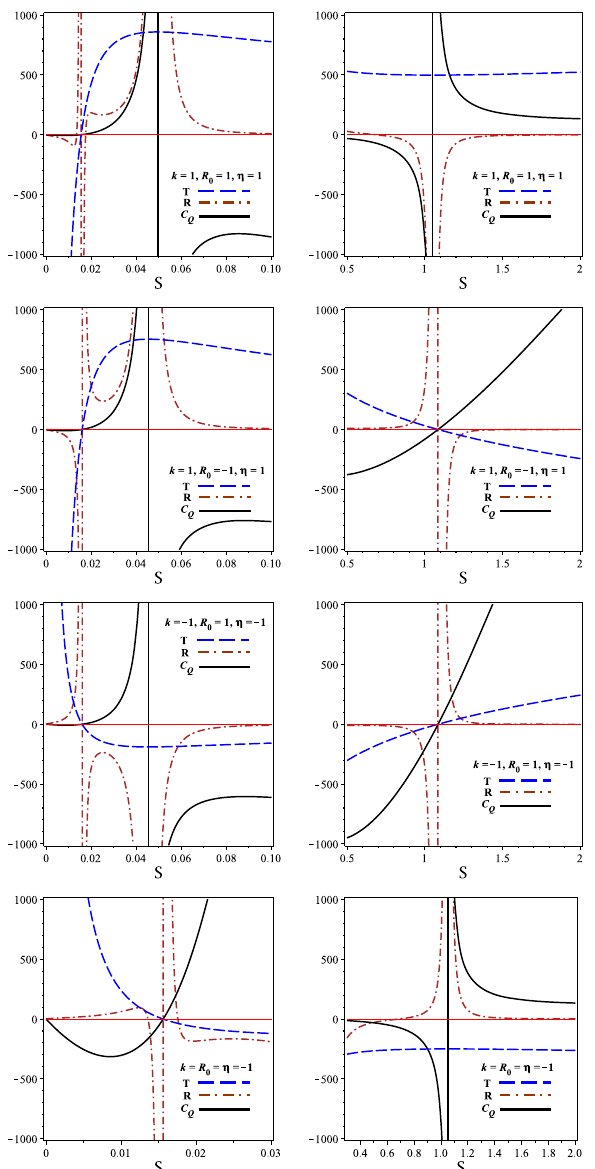
Fig. 3 The heat capacity ( C Q ) and temperature ( T ) and Ricci scalar ( R ) versus S for Q = 0 . 02 and f R = 0 . 1. We plot them in different scales to be more